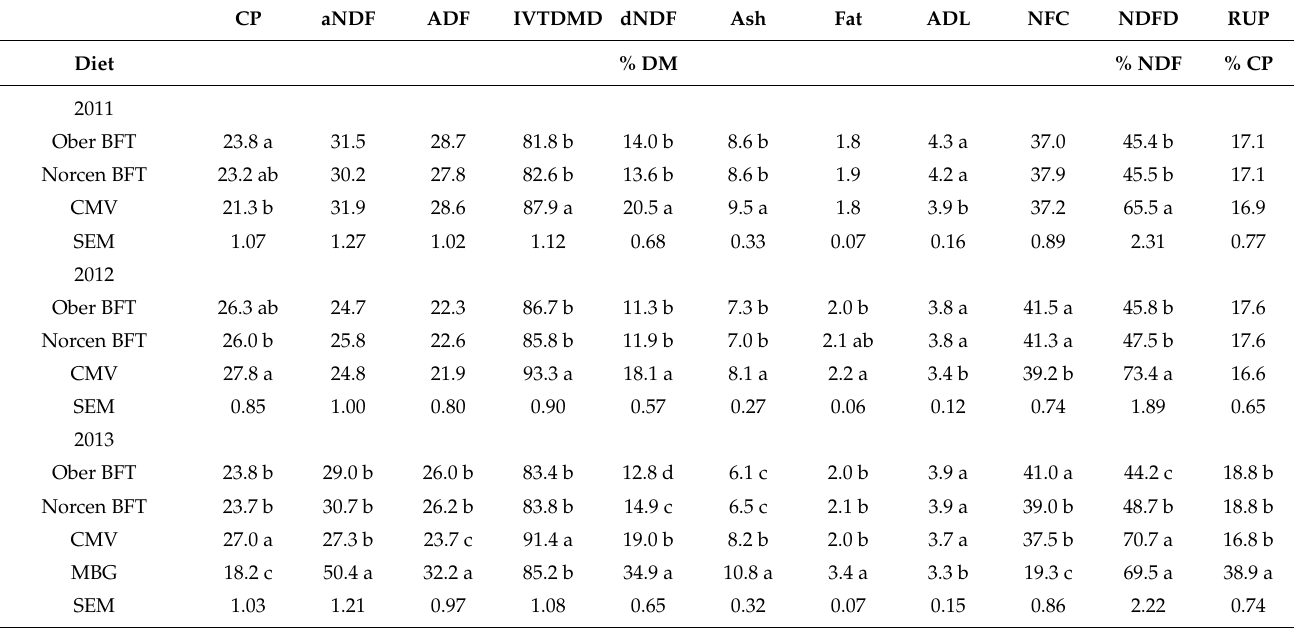
Table 2. LSMEANS of season-long forage nutritive value characteristics.